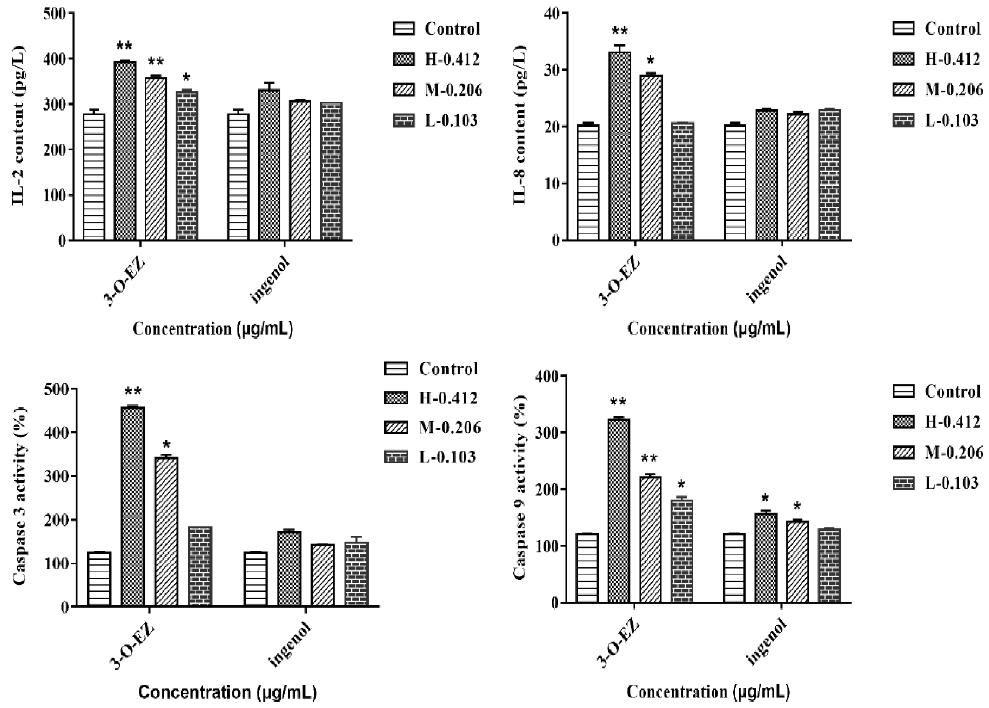
Figure 7. Caspase-3, Caspase-9 activities and IL-2, IL-8 content in zebrafish embryos. (* p < 0.05, ** p < 0.01 compared to control